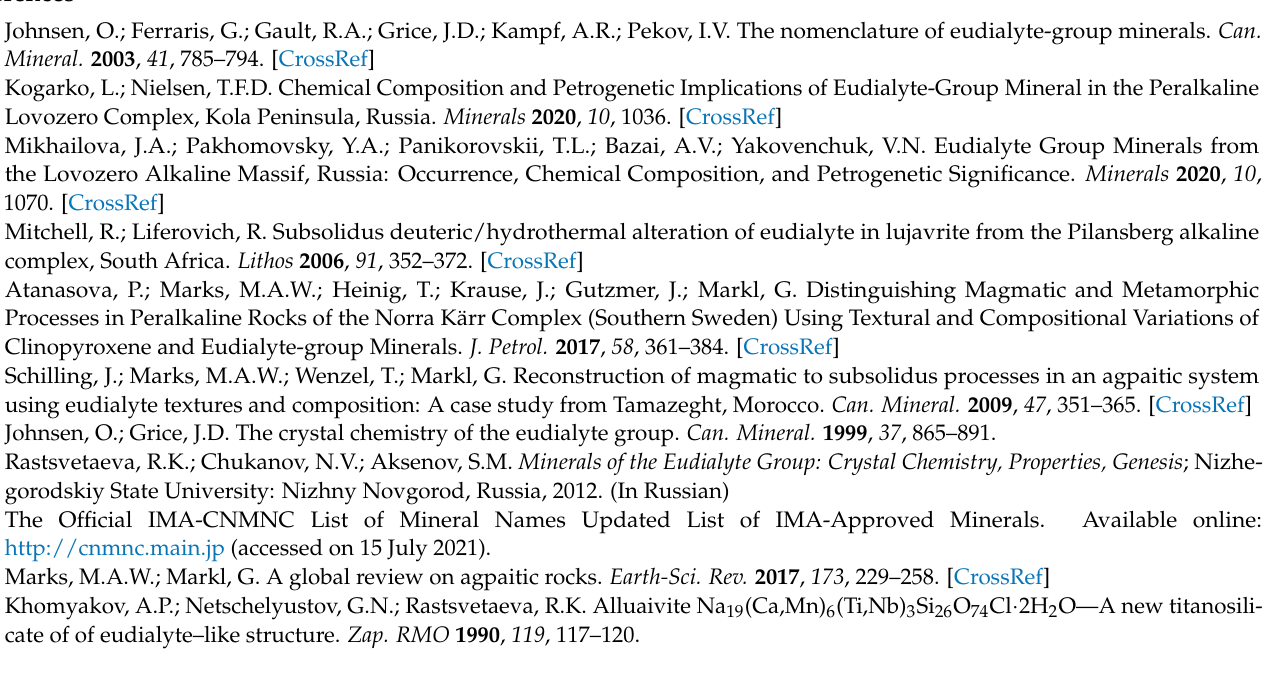
Table S2: Anisotropic displacement parameters in the LV-153/178 EGM sample, Table S3: Selected interatomic distances in the LV- LV-117/226 EGM sample, Table S4: Anisotropic displacement parameters in the LV-117/226 EGM